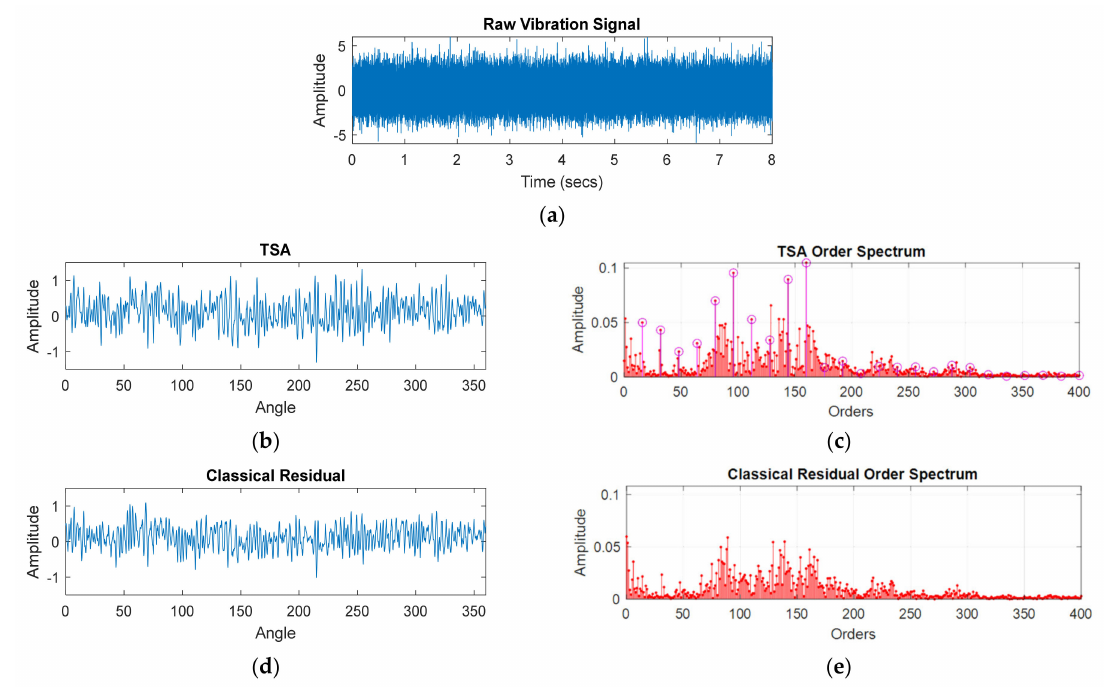
Figure 9. Signal processing flow demonstrated with real data; ( a ) Raw time-based vibration data; ( b ) TSA signal represented as a one complete rotation of the gear; ( c ) Order spectrum of the TSA signal, with gear mesh frequencies clearly visible in pink; ( d ) Classical residual signal; ( e ) Order spectrum of classical residual shows dominant mesh frequencies removed.